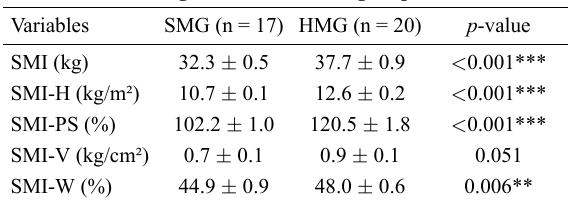
Table 1. Study criteria for the classification of standard and high skeletal muscle